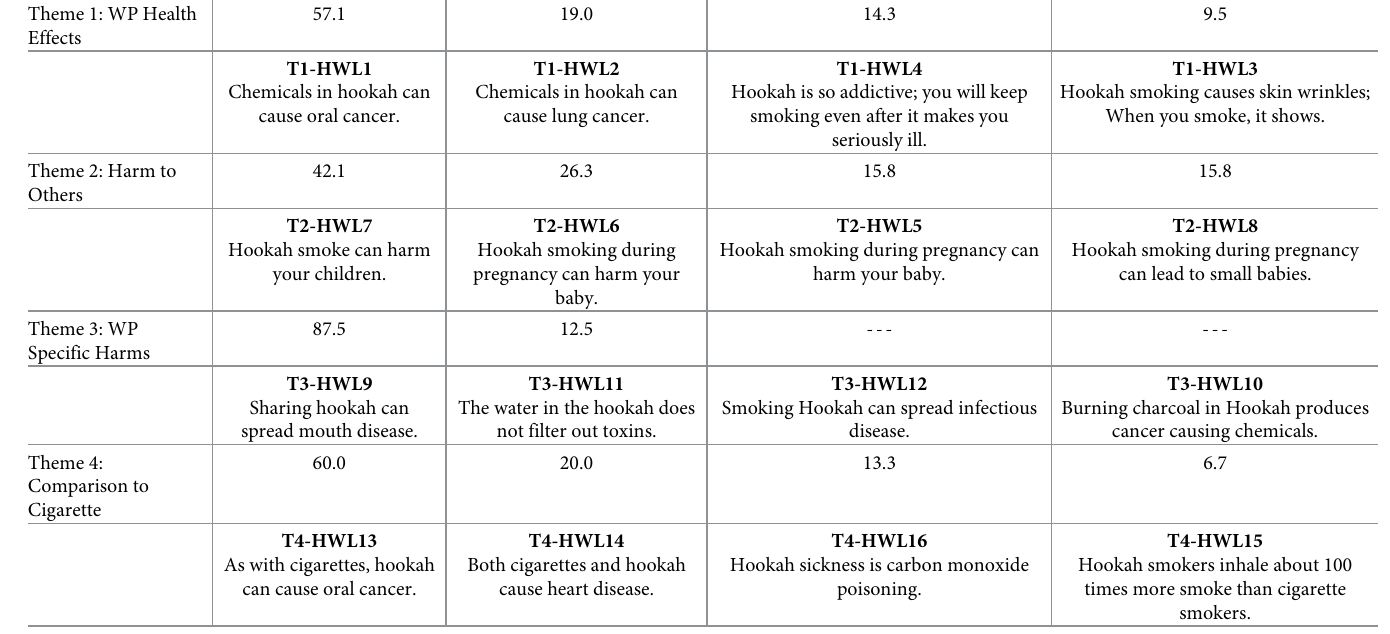
Table 4. Health warning labels ranking in each theme ordered from the top to the least ranked